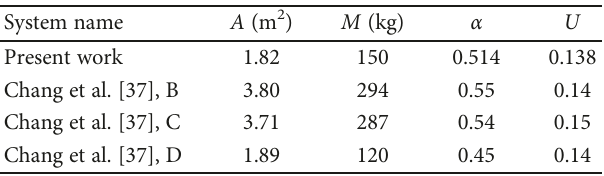
Figure 9: Graphical plot of the experimental results and the linear fi tting. Table 7: System thermal performance compared with those in previous